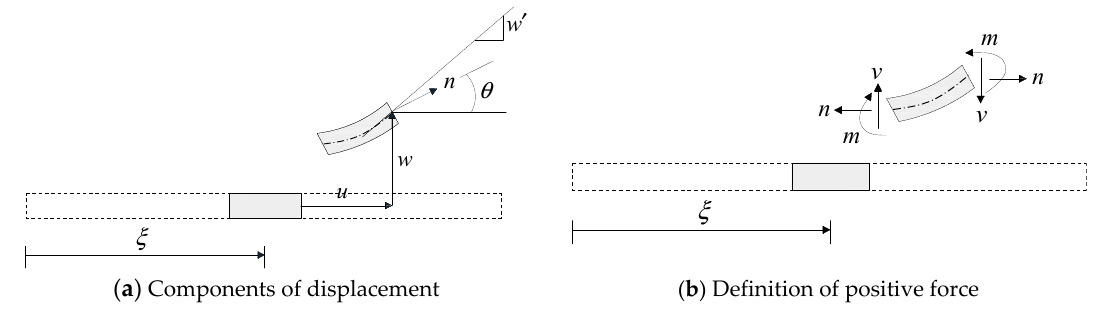
Figure 1. Timoshenko beam.